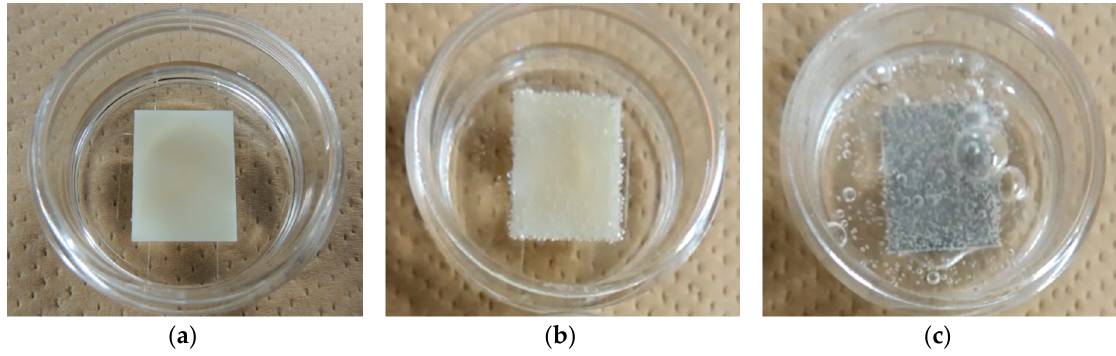
Figure 5. Photographs of the ABS samples: ( a ) untreated ABS; ( b ) Pt-particle/ABS; and ( c ) Pt-film/ABS.